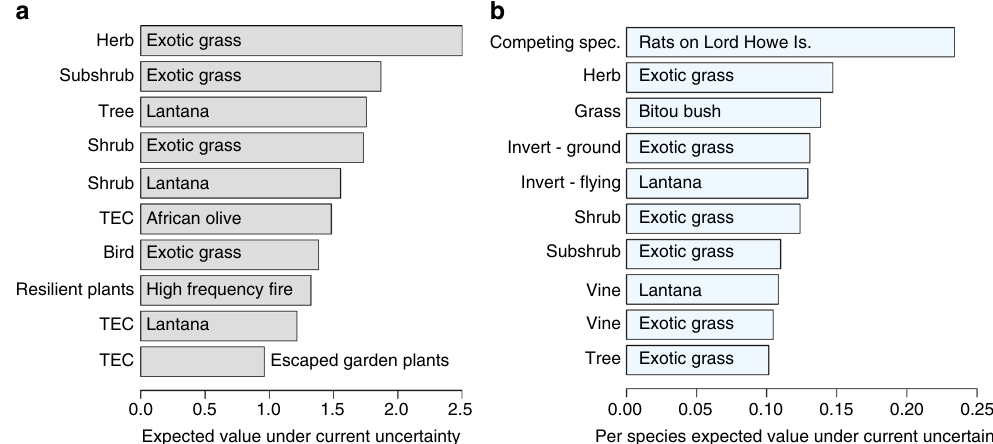
Fig. 4 Expected gain in persistence for the 10 species groups that would gain most from threat management under current uncertainty. Gain is measured relative to no management. Plots a , b show the species groups with highest total gain in persistence and per-species gains, respectively. In each plot, the y - axis lists the species group that is impacted by the threat listed within the bars. For example, in a , the species group that has highest expected value from management is Herbs (species group) affected by Exotic grasses (threat). Note that the abbreviation ‘ TEC ’ stands for threatened ecological community